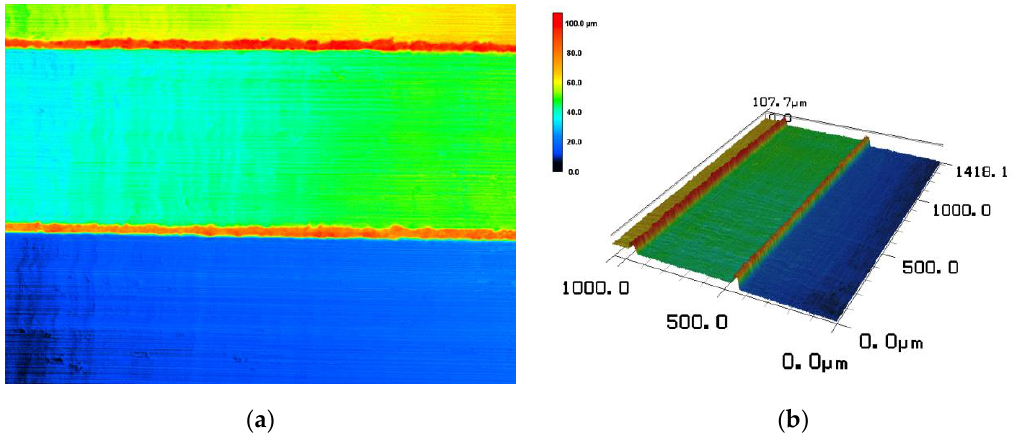
Figure 16. The observation of microtexture ( a ) height profile and ( b ) 3D morphology.